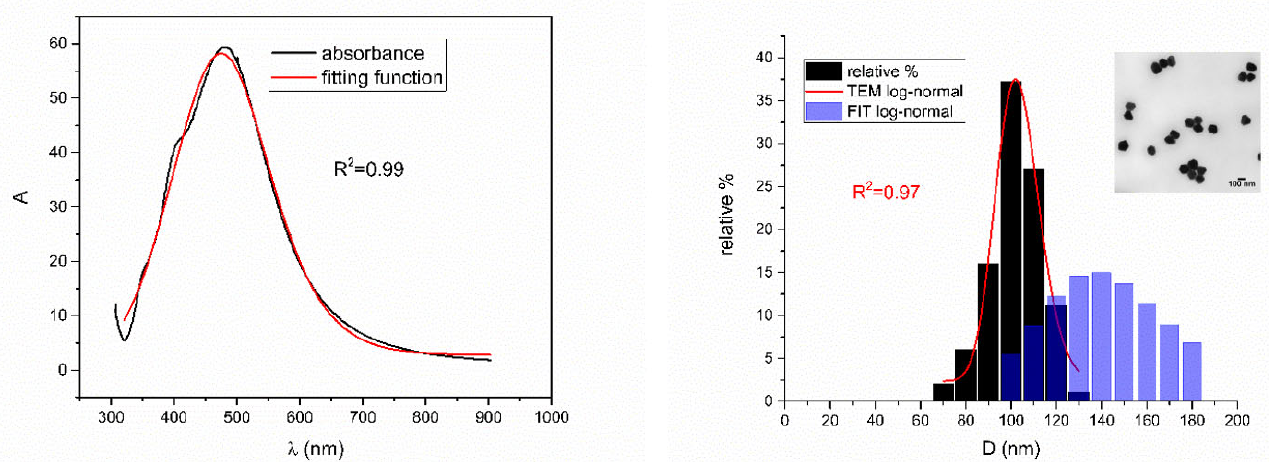
Figure 13. UV ‐ Vis spectrum with fitting function ( left ) for sample BioP_10. Reported and recon ‐